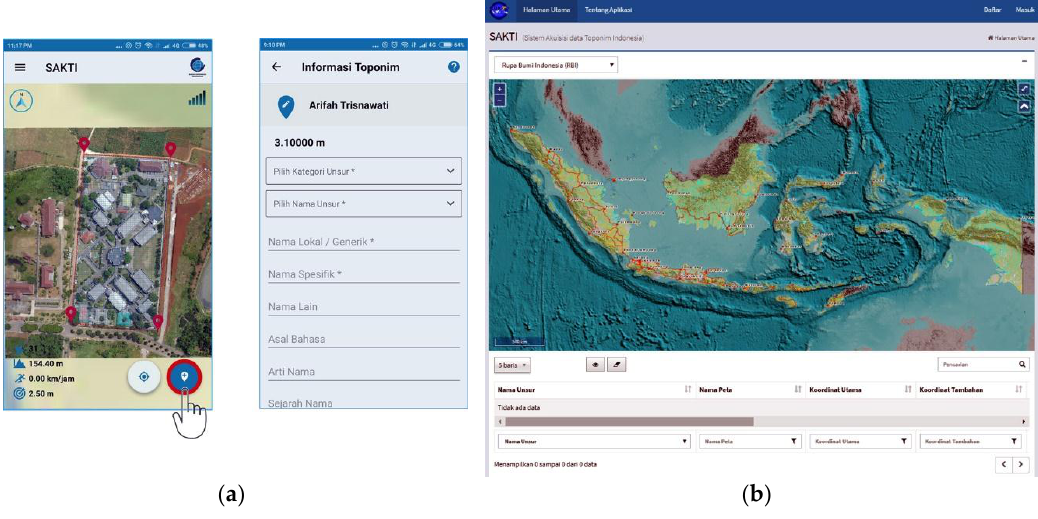
Figure 6. Selected screenshots of SAKTI (Sistem Akusisi Data Toponim Indonesia/Indonesian Toponymic Data Acquisition System): ( a ) “Name Form” for collecting toponyms in the field in SAKTI mobile application; ( b ) SAKTI Web-GIS (http://sakti.big.go.id/sakti/webgis/).